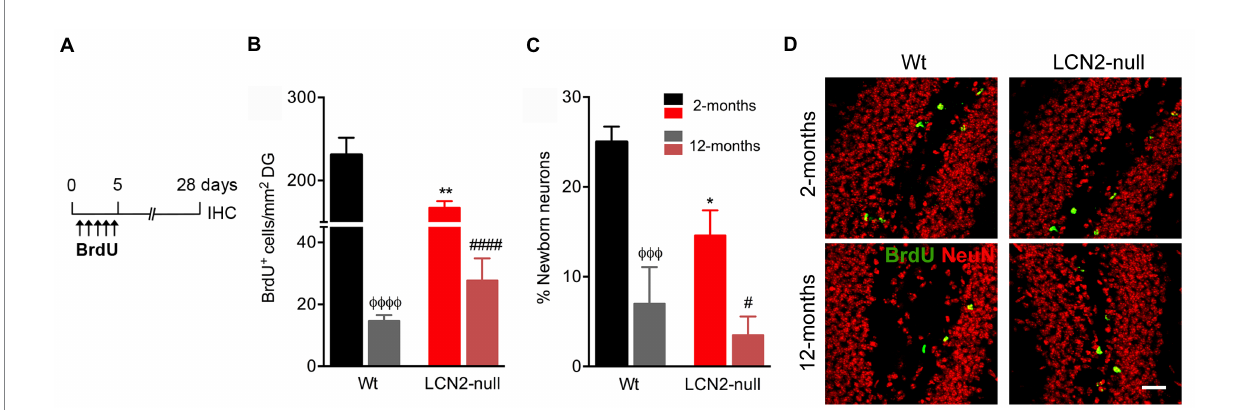
FIGURE 5 Aging reduces hippocampal neurogenesis in both Wt and lipocalin-2 (LCN2)-null animals. (A) Schematic diagram of the BrdU protocol used to label cell survival and neuronal differentiation. (B) Quantification of total number of BrdU + cells in the DG of Wt and LCN2-null mice disclosed a significant effect of aging in cell survival ( n = 4–5 mice per group). (C) Percentage of newly born neurons are significantly affected by aging, independently of animal’s genotype. (D) Representative images of BrdU and NeuN staining in the DG of Wt and LCN2-null mice. Data are presented as mean ± SEM, analyzed by two-way ANOVA with Bonferroni’s multiple comparison test. Φ Denotes differences between young and aged Wt mice; #between differences between young and aged LCN2-null mice; *between Wt and LCN2-null mice at each matched age. #, * p ≤ 0.05, ** p ≤ 0.01, ΦΦΦ p ≤ 0.001; ΦΦΦΦ , #### p ≤ 0.0001. IHC,